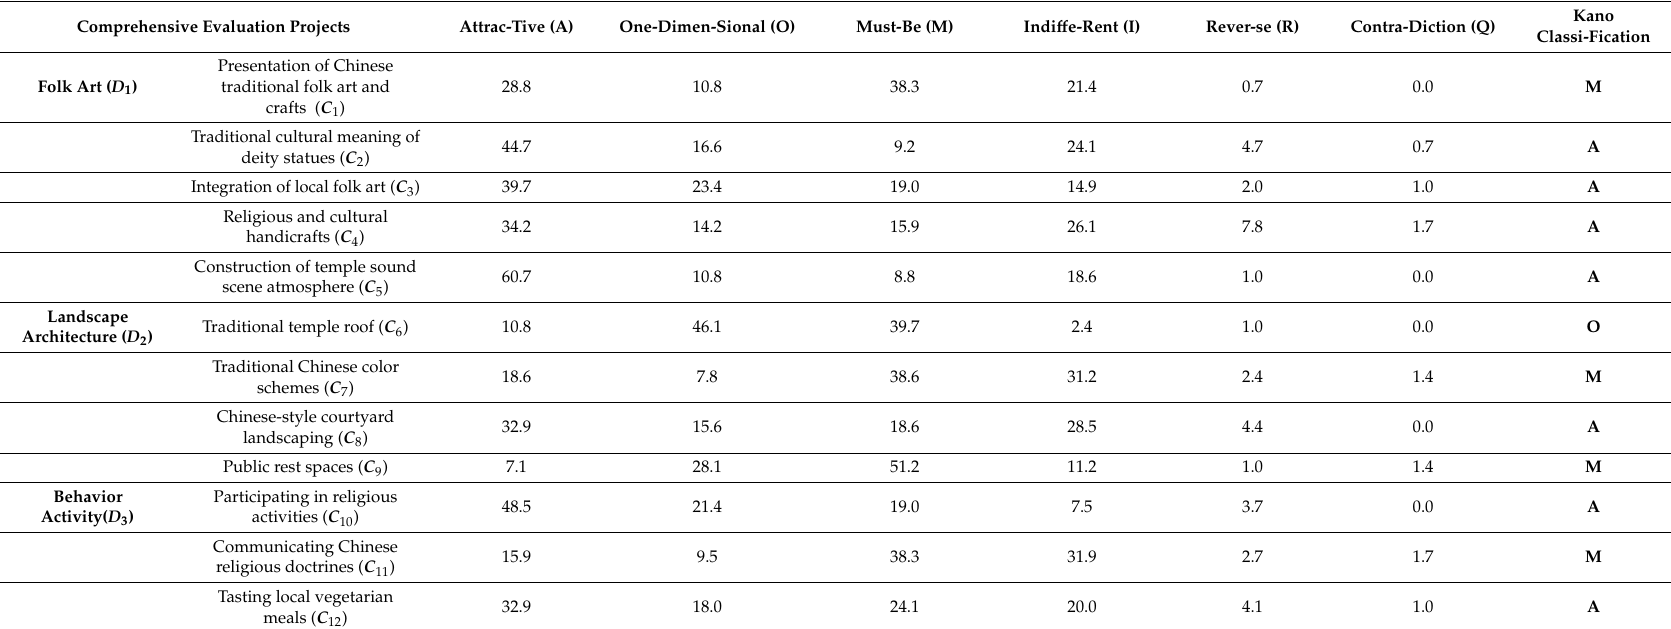
Table 3. The Attribute Classification of Kano Evaluation Items (unit: